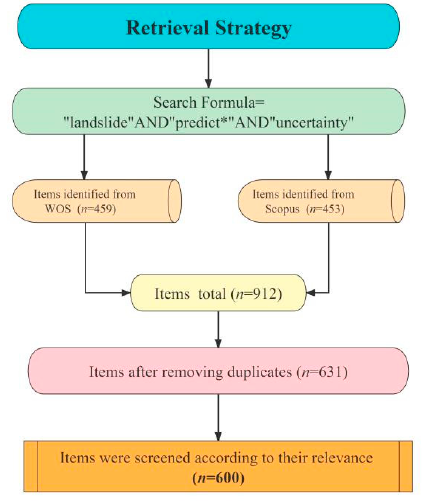
Figure 1. Flowchart of the process of searching and selecting the studies.